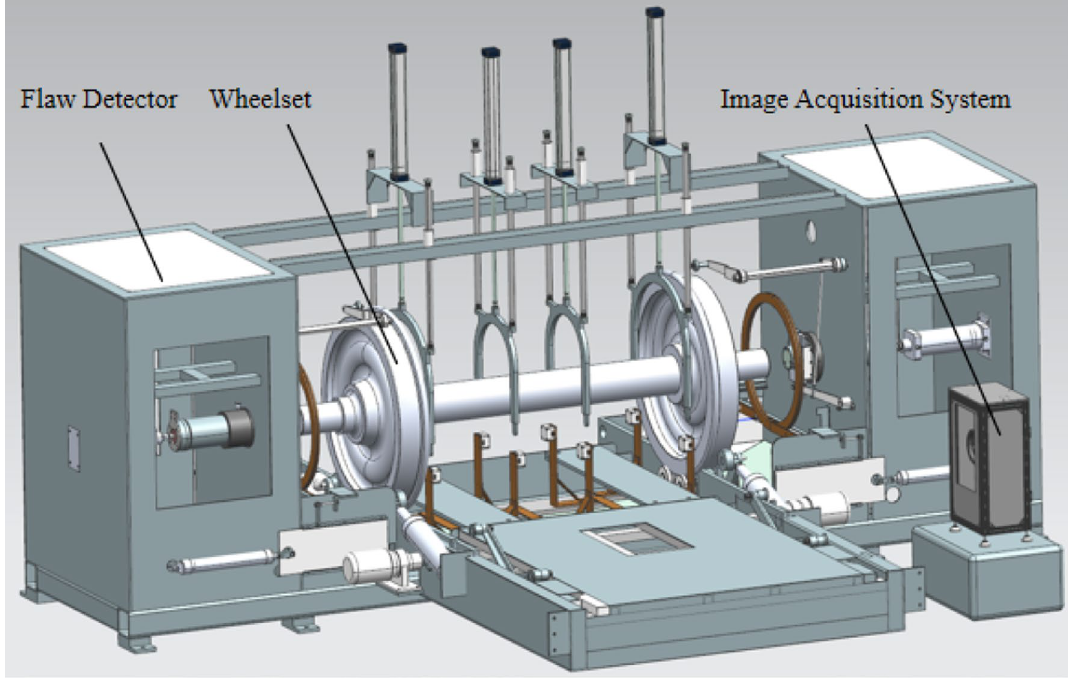
Fig. 1 Wheel axle acquisition